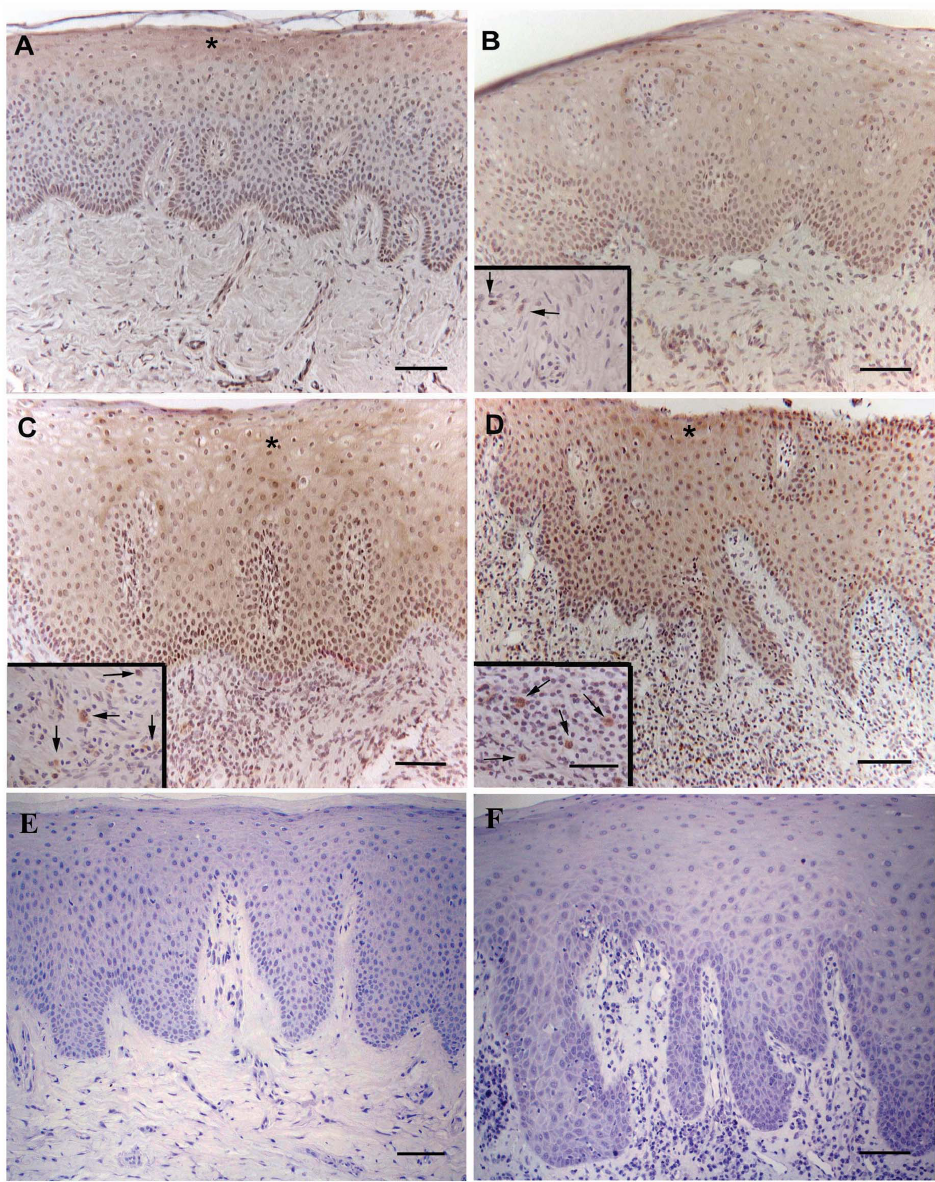
Figure 2. Expression of HtrA1, assessed by immunohistochemistry, in periodontal tissues. A) healthy gingiva; B) gingivitis tissue; C) chronic periodontitis tissue; D) aggressive periodontitis tissue. Negative control for healthy and aggressive periodontitis tissue is shown in panels E) and F) , respectively. Insets show the plasma cells positive to HtrA1 (arrows). The asterisk indicate the layer with the strongest HtrA1 immunostaining. Original magnification: 200x; scale bar: 50 m m. Original magnification of insets: 400x; scale bar: 25 m